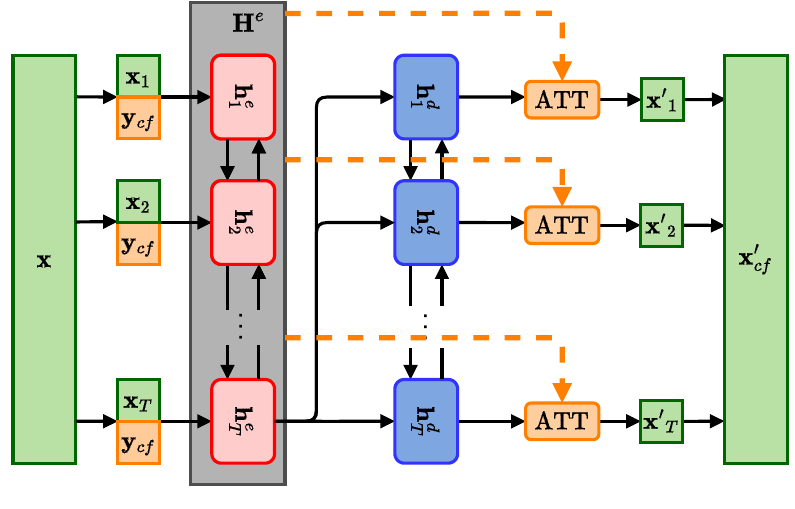
Figure 8. Proposed